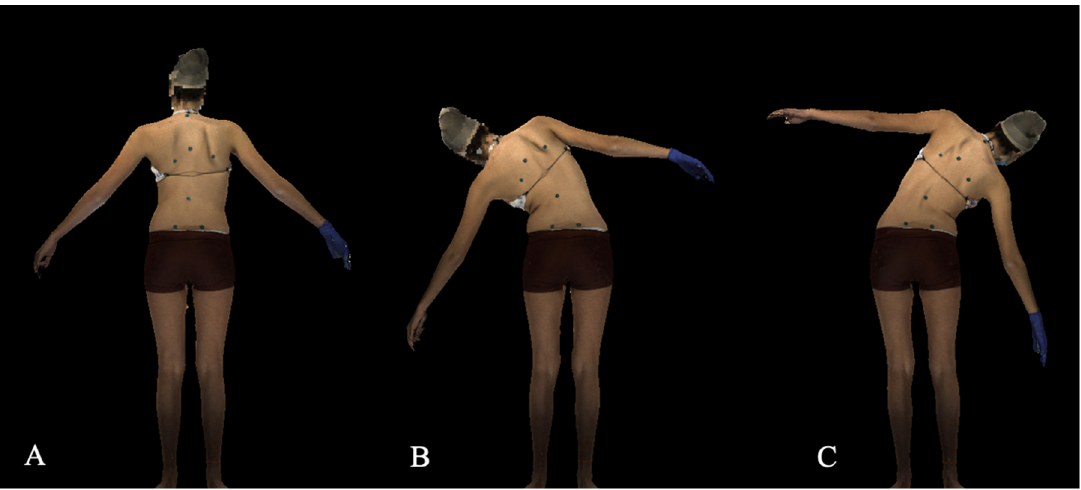
Figure 2. Lateral bend position ( A ). The A pose, with arms raised approximately 45 degrees laterally away from the body. ( B ). Subject posing with maximal bend to the left. ( C ). Subject posing with maximal bend to the right.